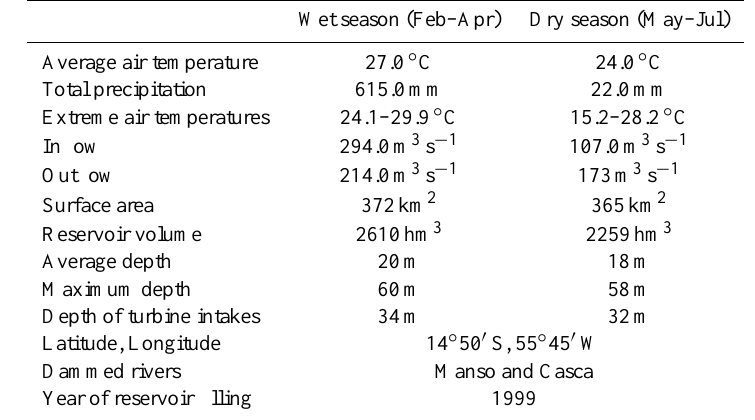
Table 1. Mean general characteristics of Manso